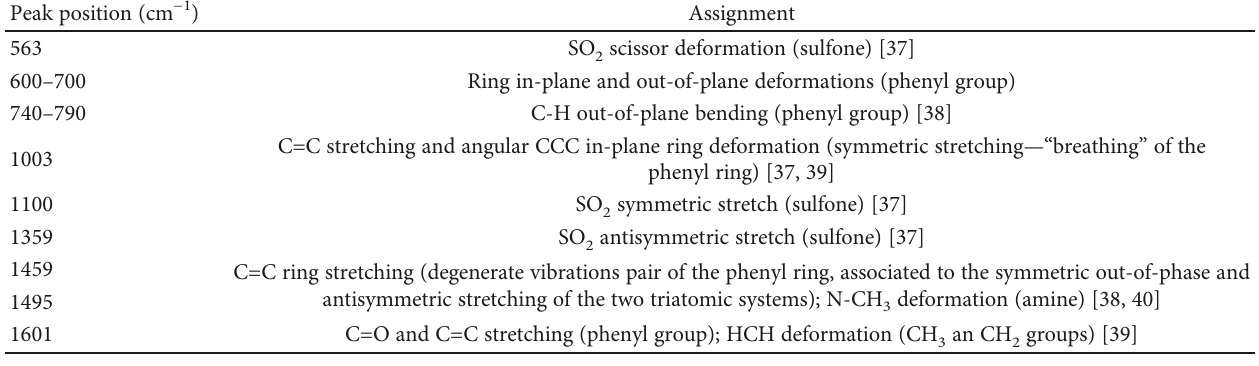
Table 1: Assignments of the main Raman bands of dipyrone found in Figure 3 based on the literature of vibrational spectroscopy. Peak position (cm − 1 )